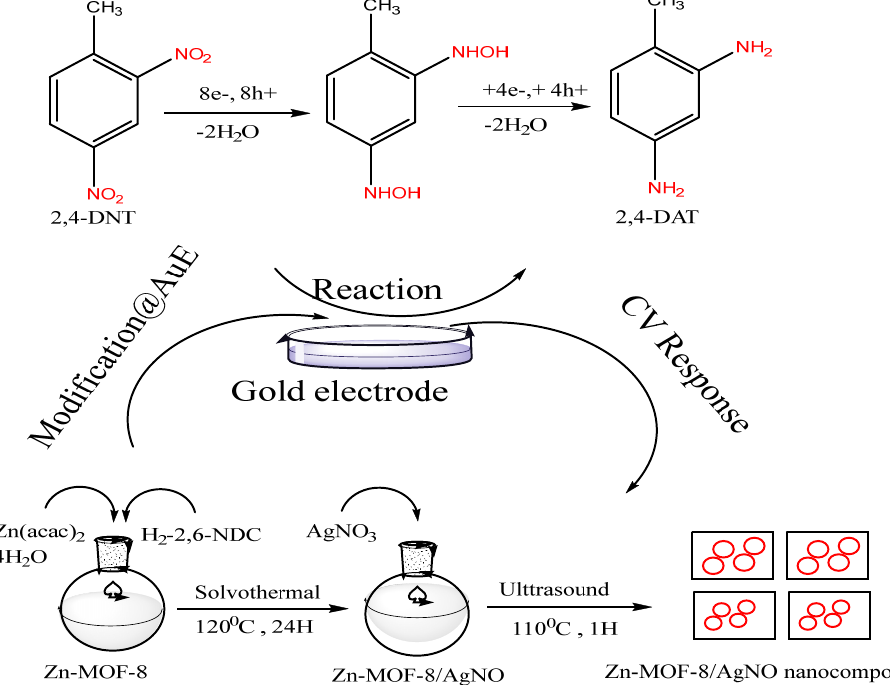
Figure 22. Synthesis of Zn-MOF-8 on a gold electrode and its composite form; 2,4-DNT reduced and depicted by CV.